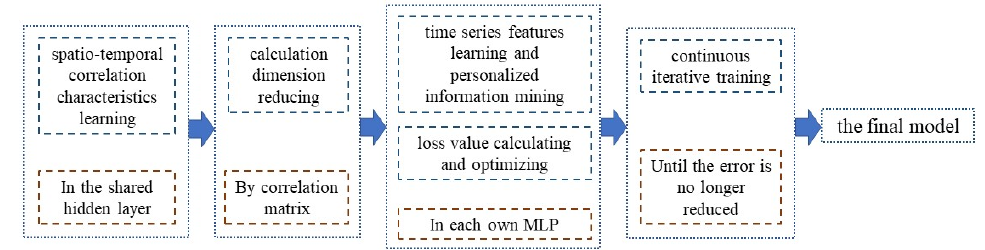
Figure 4. Data flow of the MLP after the input.